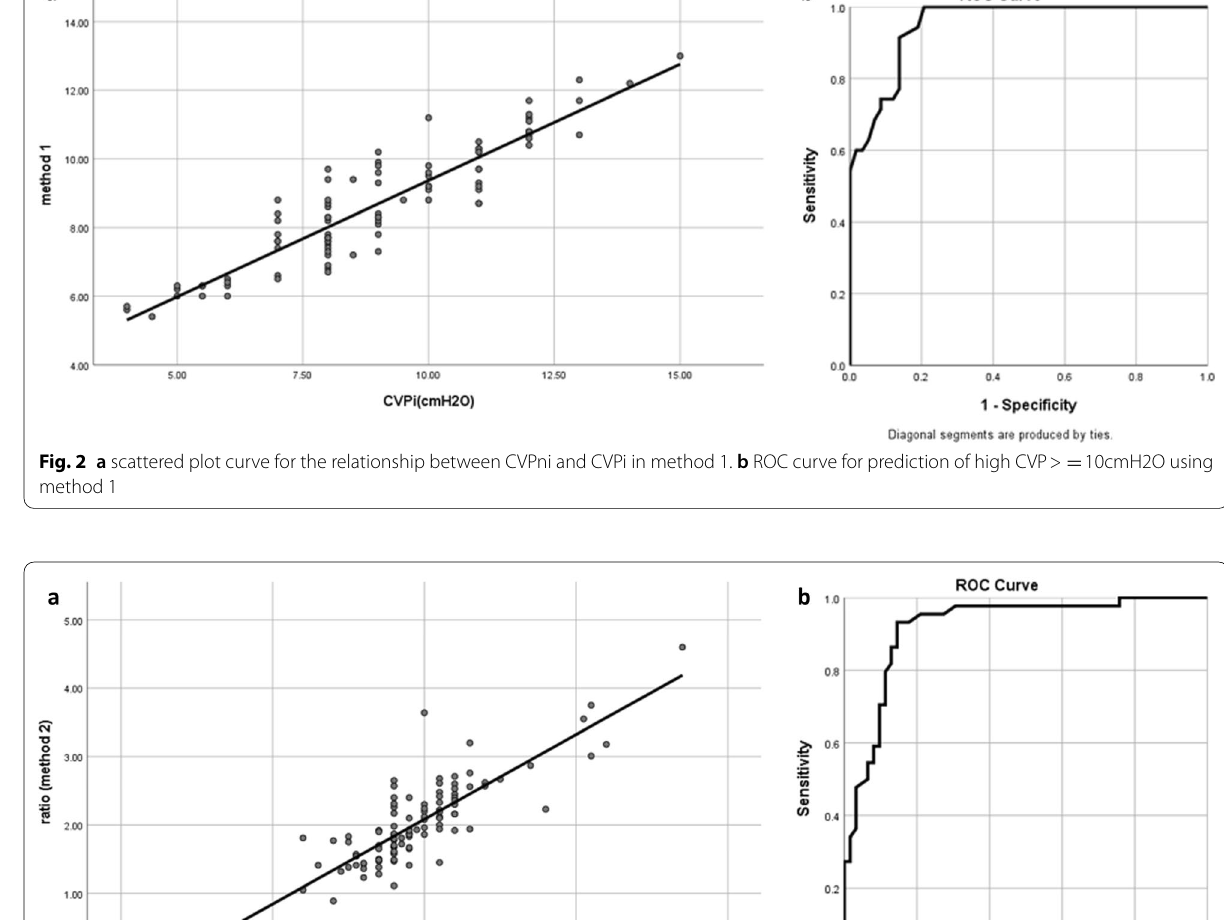
Fig. 3 a scattered plot curve for the relationship between IJV/CCA ratio and CVPi in method 2. b ROC curve for prediction of high CVP > 10cmH2O using method =